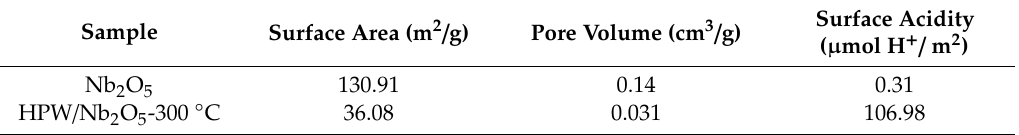
Table 3. Textural and acidity properties of Nb 2 O 5 and HPW / Nb 2 O 5